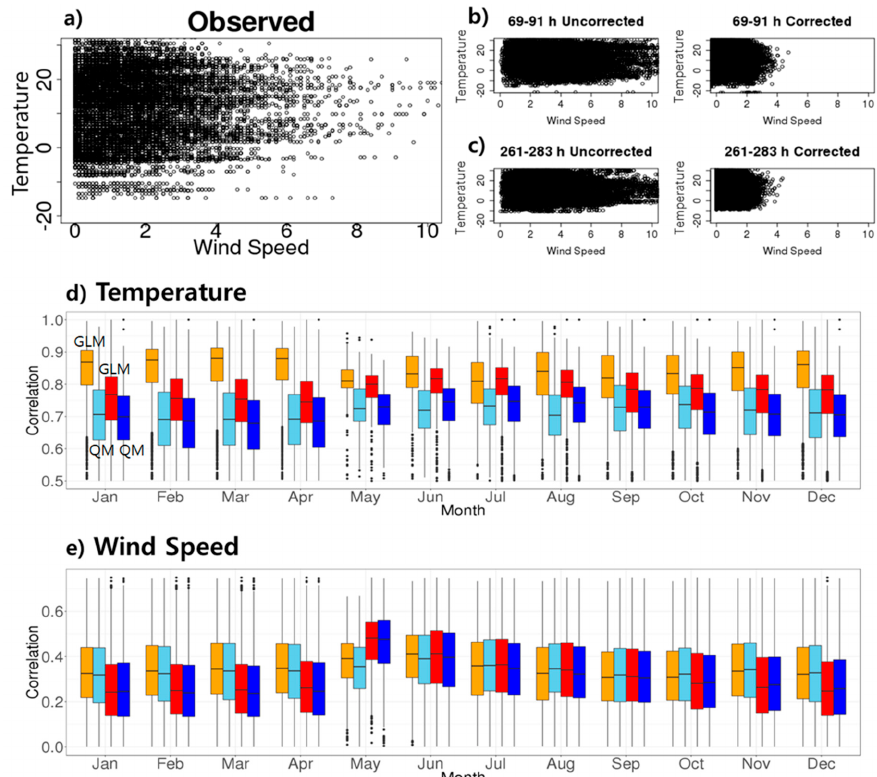
Figure 8. Scatter plot of temperature and wind speed during the period of May 2017–April 2018 for ( a ) the observed, ( b ) the uncorrected and corrected LAMP for 69–91 h, ( c ) same as ( b ), but for 261–283 h. ( d ) and ( e ) show monthly Pearson correlation of bias correction with a generalized linear model (GLM) and a quantile matching (QM) method in the 69–91-h range (orange for GLM, sky blue for QM) and 261–283-h range (red for GLM, blue for QM).